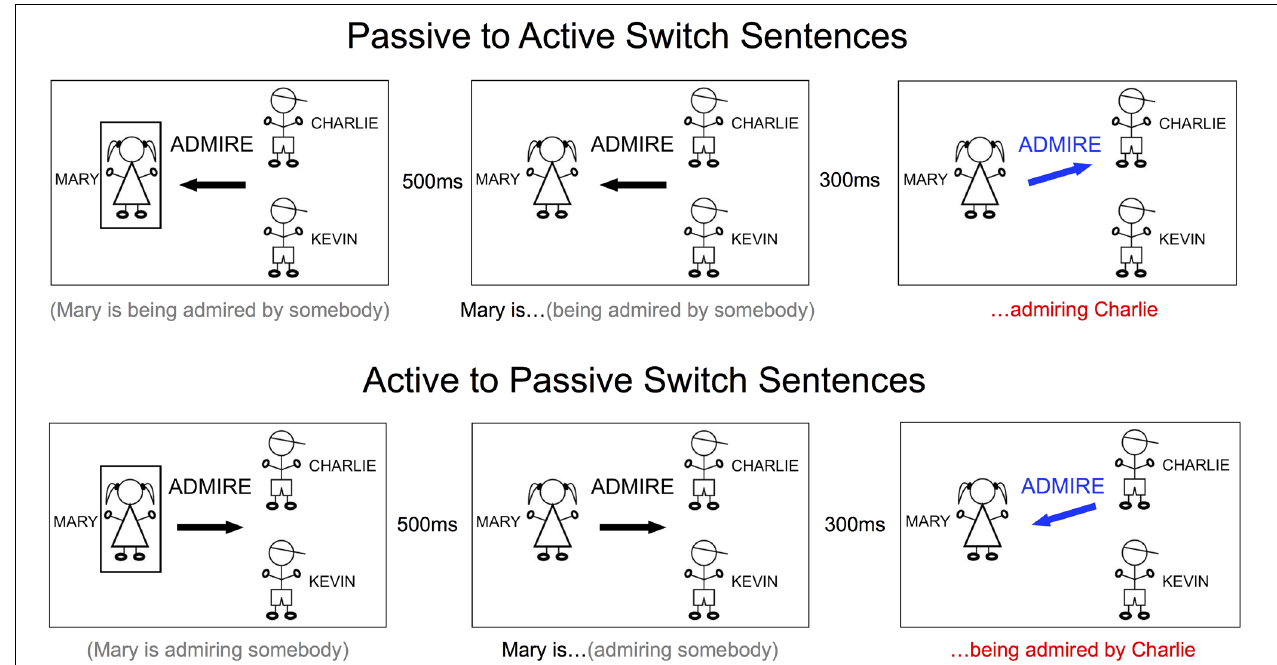
FIGURE 2 | Sample trials for switch (perturbation) sentences, passive to active and active to passive. The words under each picture indicate what the subject was able to plan (in gray) and what the subject produced, or began to produce (in black), and what the subject produced after updating the sentence construction (in red) when that cue was presented. Only the image within the large black rectangles was part of the stimulus. LEFT: PREP stage, during which the subject prepared to begin producing the sentence with either active or passive construction. MIDDLE: GO stage, during which subject was cued to begin producing the incomplete sentence. RIGHT: FINISH stage, during which the completing information was presented. On switch trials, the subject would have to change from one structure to another.